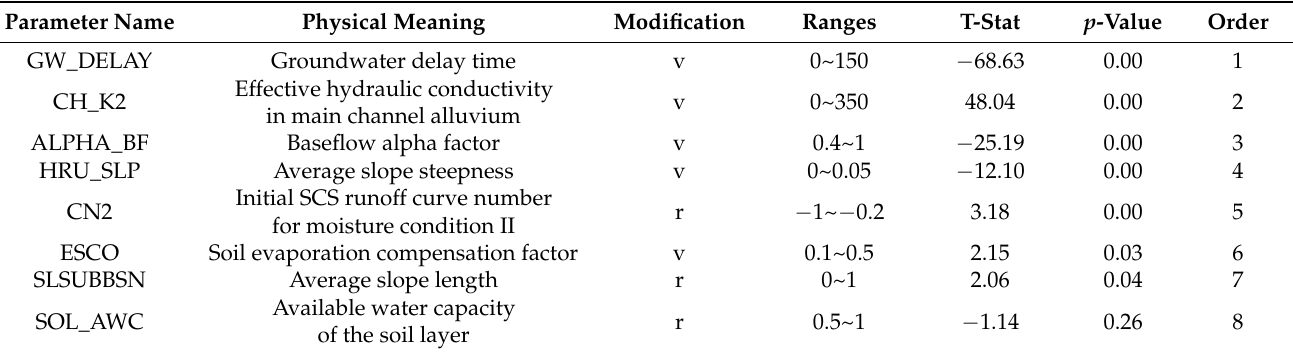
Table 2. Results of the parametric sensitivity analysis.